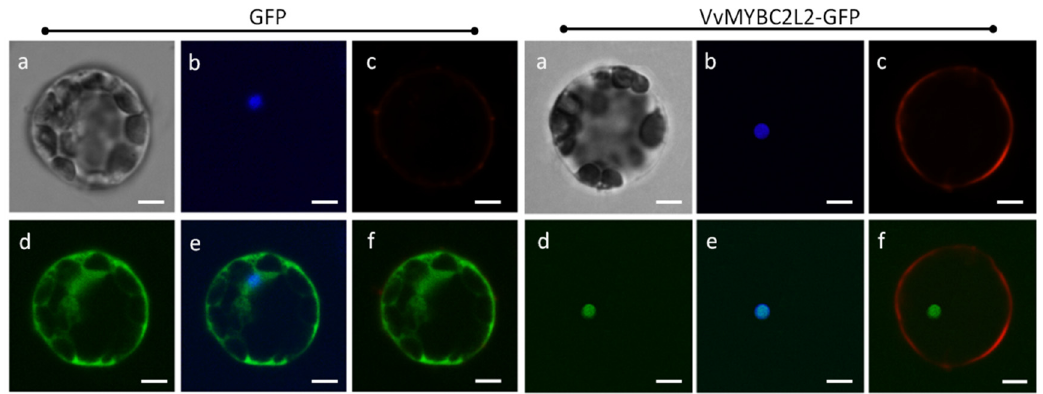
Figure 2. Subcellular localization of the VvMYBC2L2 protein. Transient expression of the VvMYBC2L2-GFP fusion protein was performed in A. thaliana mesophyll protoplasts. The fluorescent signal was detected by confocal laser-scanning microscopy. Bright field ( a ), DAPI ( b ), Dil (Lipophilic membrance dye) ( c ), GFP ( d ), GFP + DAPI merge ( e ), GFP + Dil merge ( f ). Bars correspond to 10 μ m.